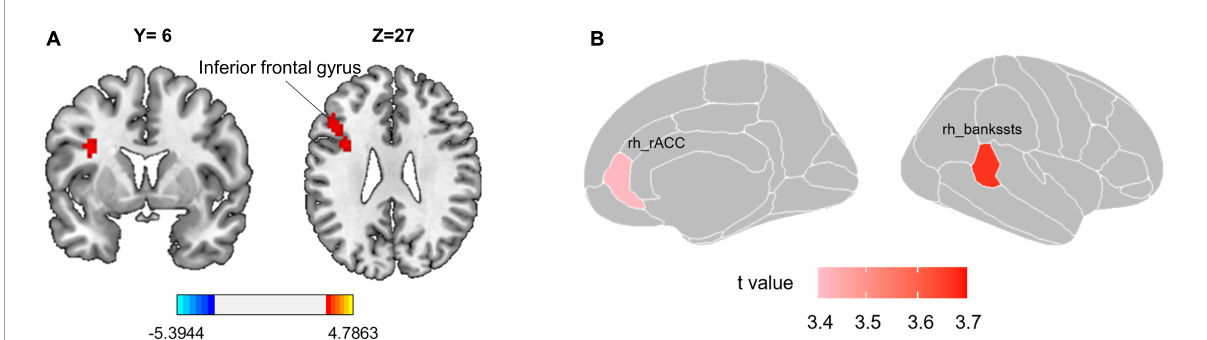
FIGURE1 Group differences in local functional metric and surface morphology. (A) Patients with CS have significantly higher ALFF value in the left inferior frontal gyrus. The red color reflects ALFF values greater in CS patients than in the HC group. Gaussian Random Field theory (GRF) correction with voxel-level p < 0.001 and cluster-level p < 0.05. (B) Cortical surface area differences between CS patients and HC. T -values of two altered brain regions in the surface area of the right hemisphere. Positive (red) values reflect cortical area larger in CS patients than in the HC group, FDR corrected p < 0.05. CS, chronic sciatica; CS, chronic sciatica; HC, healthy controls; rh, right hemisphere; rACC, rostral anterior cingulate cortex; bankssts, banks of superior temporal sulcus.